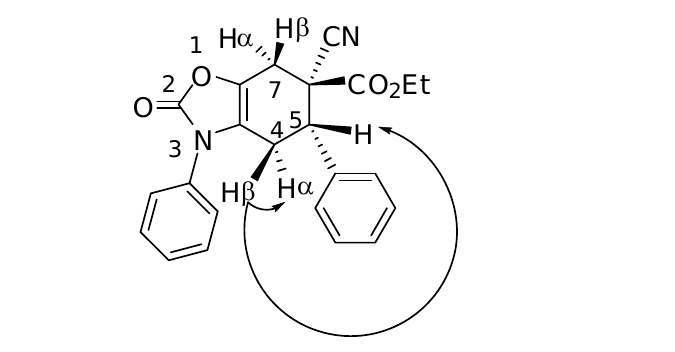
Figure 1. NOE effects observed upon irradiation of proton H-4 β for the adduct 7a